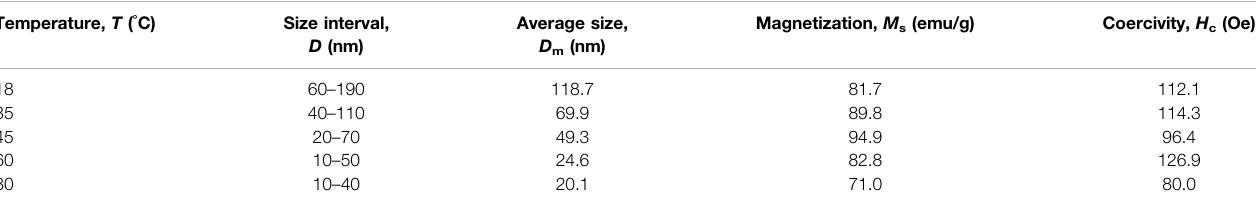
TABLE 1 | Particle sizes and magnetic parameters of Fe 3 O 4 nanoparticles prepared at different temperatures. Temperature, T ( °